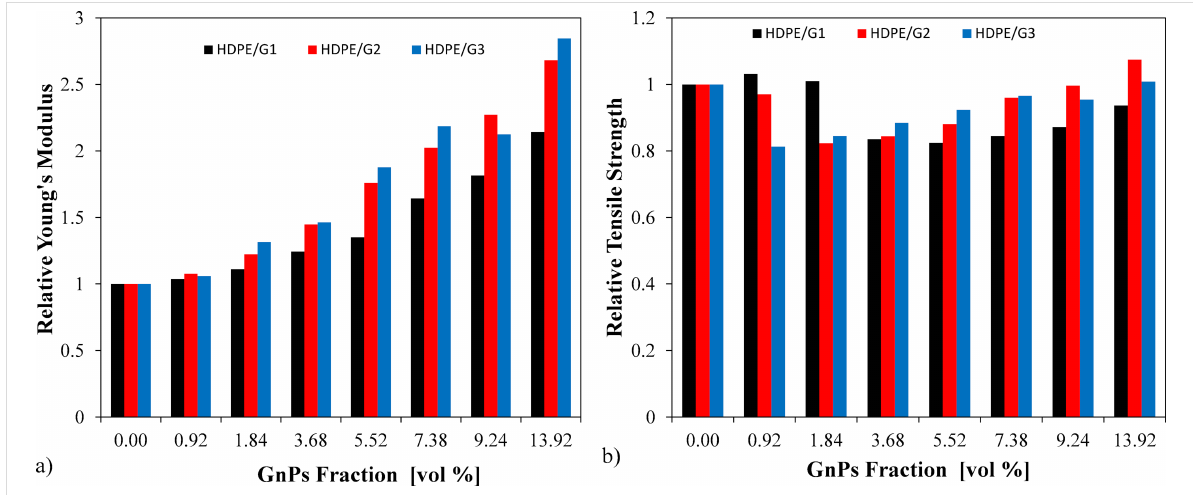
Figure 6: Relative mechanical properties of the HDPE/GnP nanocomposites: a) Young’s moduli and b) tensile